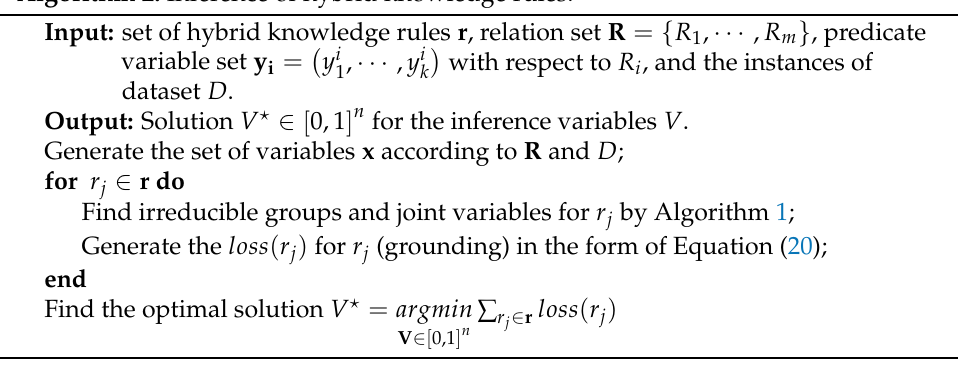
Algorithm 2: Inference of hybrid knowledge